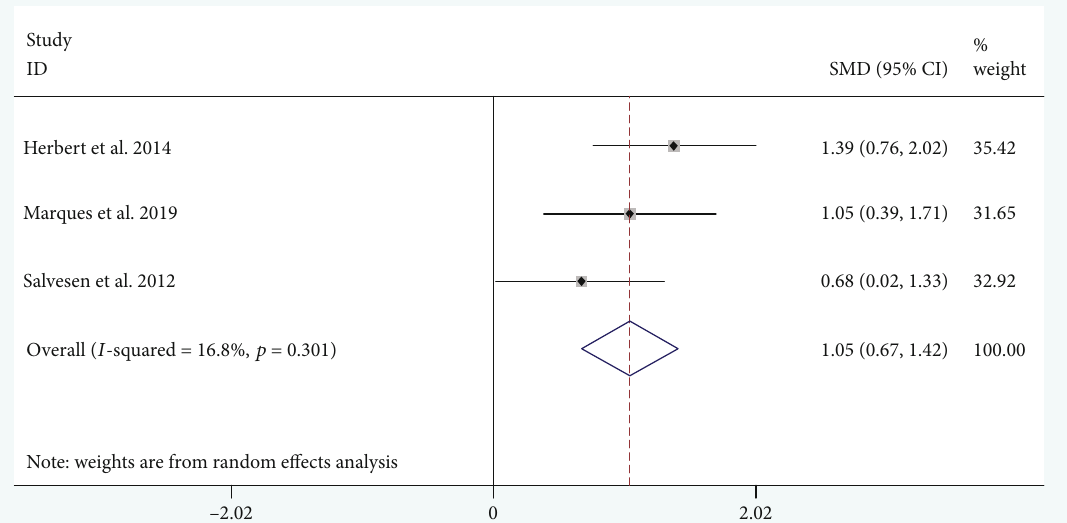
Supplementary 1 . Figure S1: CSF phosphorylated tau (p-tau) levels had no di ff erence between PD and MSA patients ( SMD = − 0 : 05 , 95% CI: -0.28 to 0.17). Supplementary 2 . Figure S2: there were no di ff erences in CSF GFAP levels between PD and MSA patients ( SMD = 0 : 20 , CI: -0.21 to 0.60). Supplementary 3 . Figure S3: a meta-analysis of CSF fms- related tyrosine kinase 3 ligand (Flt3 ligand) revealed that MSA and PD patients had similar levels of Flt3 ligand ( SMD = − 0 : 50 , 95% CI: -1.48 to 0.48). Supplementary 4 . Figure S4: through meta-analysis of 4 stud- ies, CSF DJ-1 levels in both MSA and PD patients lacked a signi fi cant e ff ective size ( SMD = 0 : 61 , 95% CI: -0.39 to 1.62). Supplementary 5 . Supplementary Table 1: characteristics of studies included in the meta-analyses. Supplementary 6 . Supplementary Table 2: summary of Egger ’ s test outcomes for measurements of CSF biomarker levels.